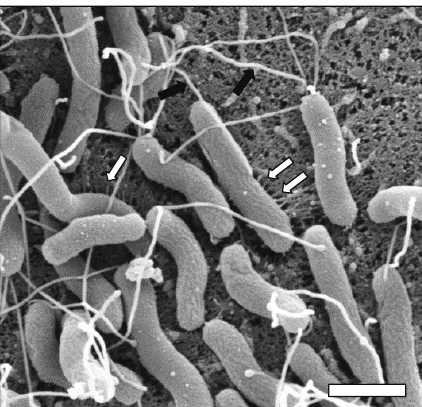
Figure 2: High resolution scanning electron micrograph of H. pylori in contact with human gastric epithelial cells. H. pylori virulence factors including flagella (black arrows) and cag -T4SS pili (white arrows) are present on the bacterial cell surface during host-pathogen interaction. Flagella aid in cell motility through the mucus layer to penetrate host tissues. The cag -T4SS pili induce proinflammatory and oncogenic cellular responses. Magnification bar indicates 1 𝜇